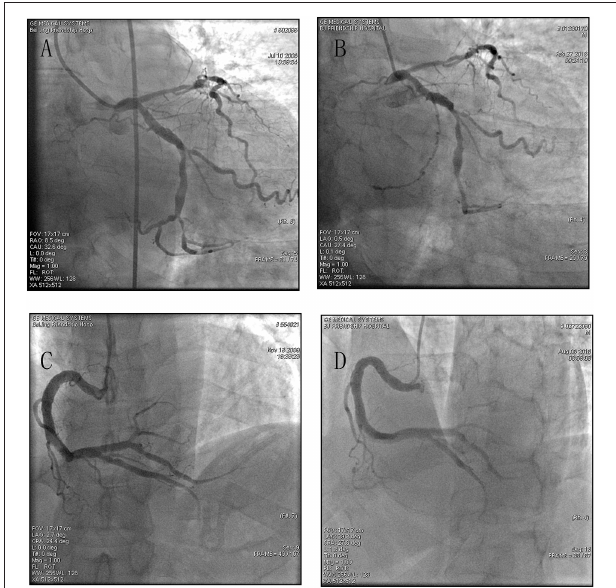
FIGURE 3 | Typical CAG images from two CAE patients. The tube in each figure at the opening of vessel was a catheter used for operating CAG. Its diameter was 5 French (1 French = 1/3mm) and it could be used as a marker for measuring the diameter and length of ectatic changes. (A) (first CAG) and (B) (second CAG): 9 years follow-up for a female CAE patient with diffused dilation in right coronary artery (RCA), the maximum diameter of RCA was 4.94 folds of the catheter or 8.23mm or at least 1.64 folds of normal RCA (normal RCA was < 5mm); (C) (first CAG) and (D) (second CAG):12 years follow-up for a male CAE patient with segmental dilation in left circumflex coronary artery (LCX), the maximum diameter of LCX was 3.46 folds of the catheter or 5.76mm or 1.76 folds of normal